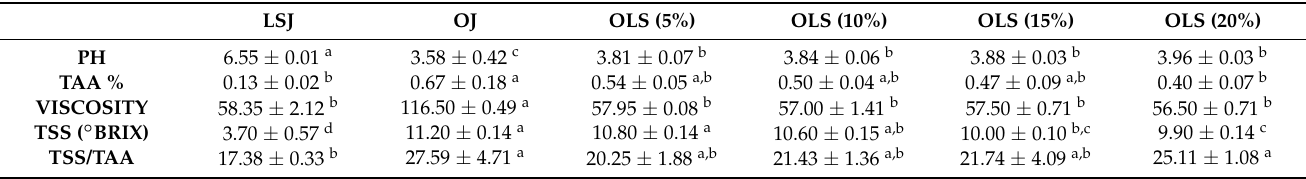
Table 3. Physicochemical properties of orange juice mixed with beetroot stem–leaf juice in different proportions.